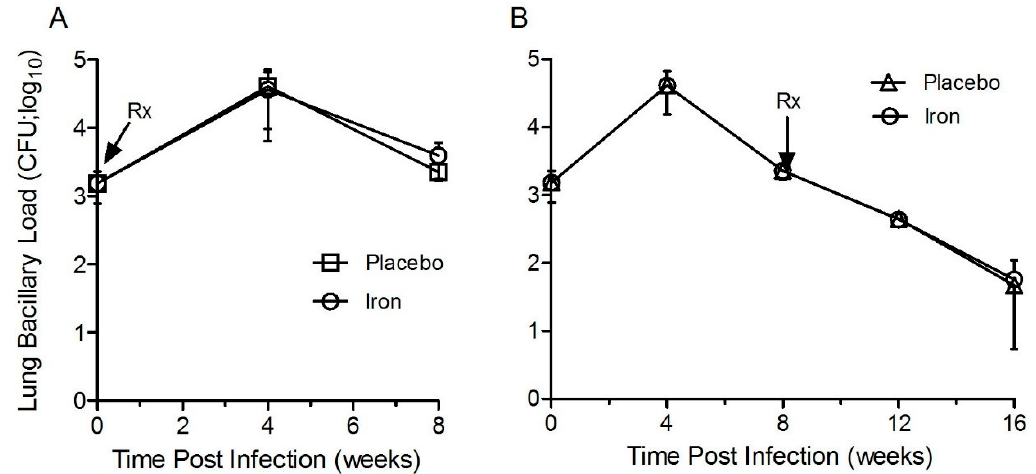
Figure 7. Effect of Fe-supplementation on the lung bacillary load of Mtb-infected rabbits. Number of bacterial colony-forming units (CFU) was determined in the lungs of rabbits supplemented with Fe or placebo during acute ( A ) or chronic ( B ) stages of Mtb infection. Data was analyzed by one-way Anova with Tukey’s multiple comparison test. Values plotted are mean +/– sd with n = 5 per group per time point. Rx denotes treatment start time (day-1 or 8 weeks post-infection). The treatment was continued for 8 weeks in both acute and chronic infection groups.